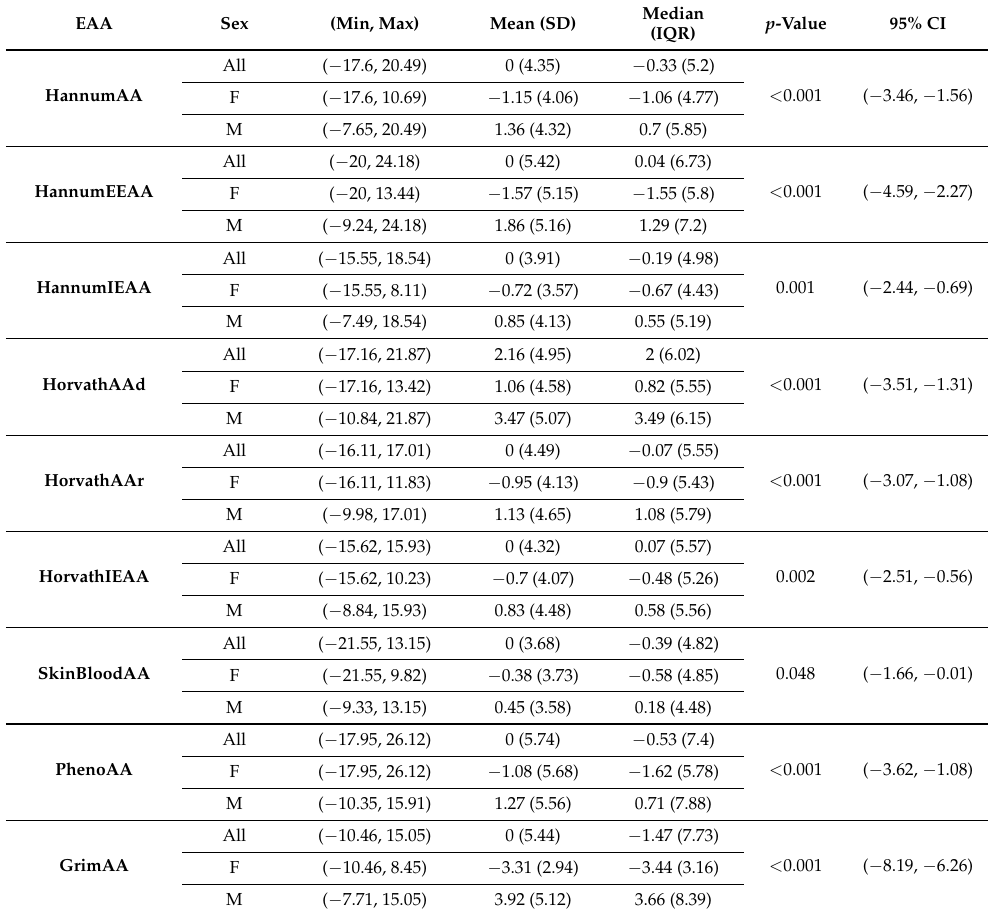
Table A2. Summary of EAAs score data for males and females. EAA scores before adjustment for sex. p -values obtained from the Welch’s t -test, testing difference between male and female groups for each EAA ( H 0 : mean value of the EAA is the same for male and female groups). EAA